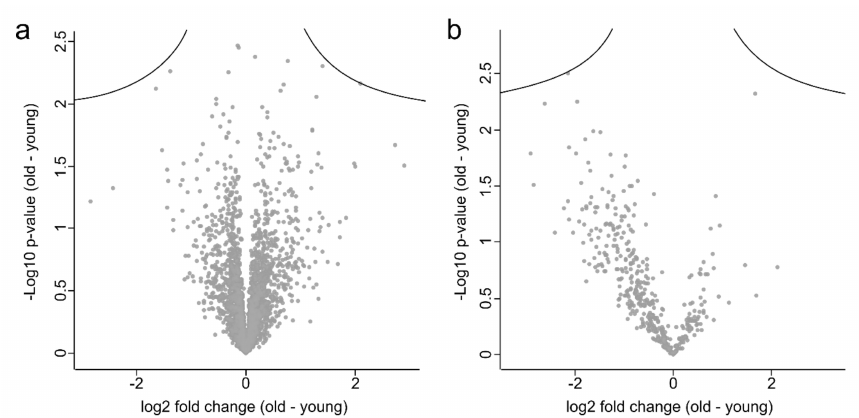
Figure A1. Volcano plot analysis of proteomes ( a ) and secretomes ( b ) of MKTPCs from older and younger individual donors. Proteins above the significance cuto ff curve (s = 0.1; FDR < 0.05) are considered